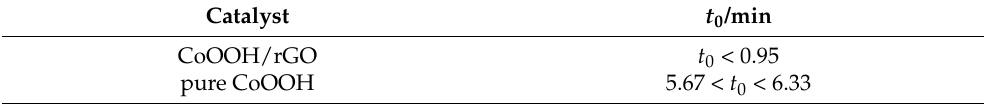
Table 2. The induction time of CoOOH/rGO and pure CoOOH in the reduction of p-NP a .